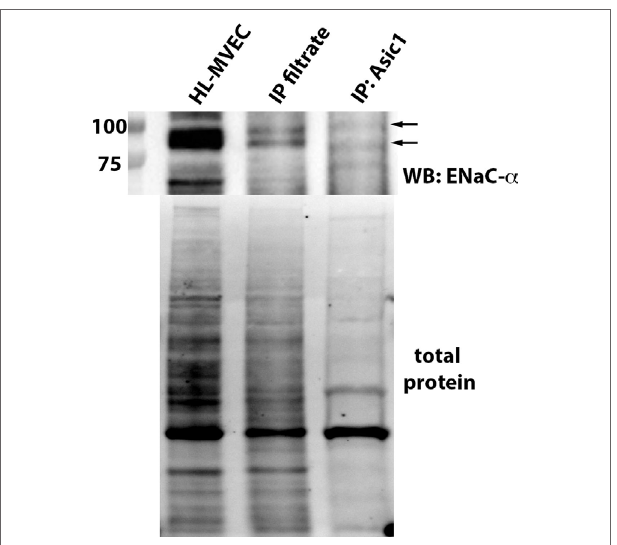
FigUre 6 | Representative immunoprecipitation experiment assessing binding of epithelial sodium channel (ENaC)- α (indicated by arrows) to native ASIC1 in human lung microvascular endothelial cells (HL-MVEC) and representative stain-free blot showing the total protein transferred to the nitrocellulose membrane before the co-IP experiment (whole HL-MVEC lysate—first lane), the filtrate after the co-IP (second lane), and the eluent (eluted from the ASIC1 antibody-decorated magnetic beads—third lane).